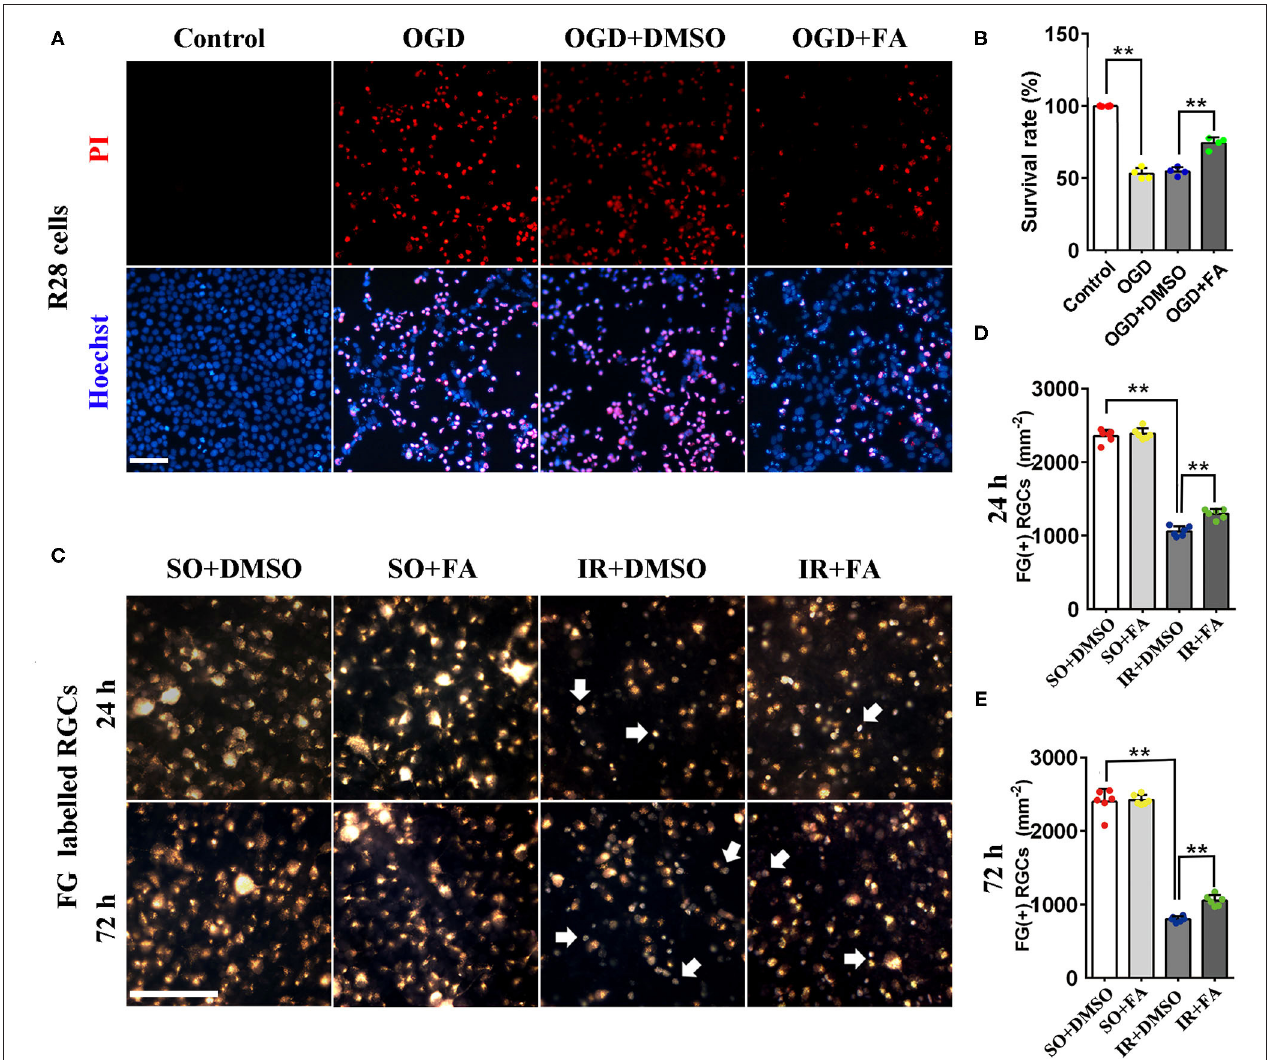
FIGURE 2 | Protective effect of PPAR α activation by FA on RGC survival in vitro and in vivo . (A) Representative photomicrographs of R28 cells stained by propidium iodide (PI, dead cells) and Hoechst (total cells). (B) The survival rate of R28 cells. (C) RGCs labeled by fluorogold (FG) taken at 1/2 retinal radius distances from the optic disk (white arrows, dead RGCs). (D,E) The average number of FG-labeled RGCs at 24 h/72h post-IR modeling. Data are the mean ± SEM; ** p < 0.01. Scale bar = 50 µ